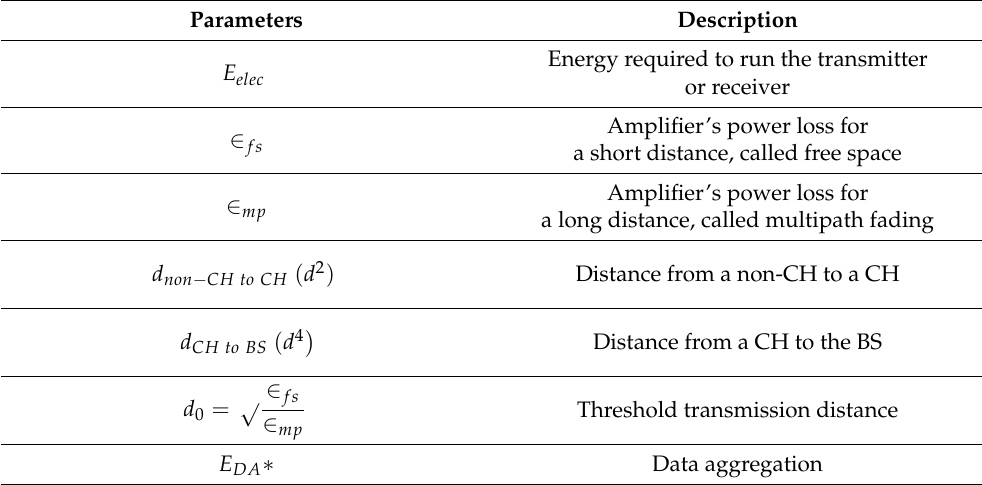
Table 1. The energy model’s parameters and their